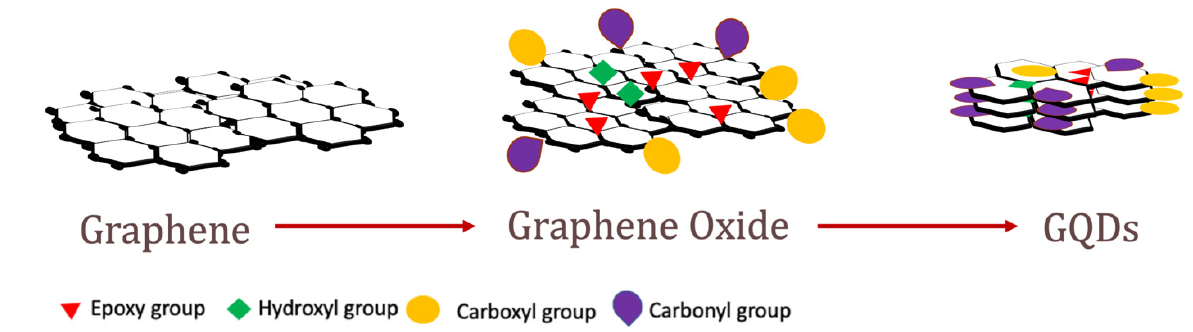
Figure 1. Structure of Graphene, Graphene Oxide and GQDs.